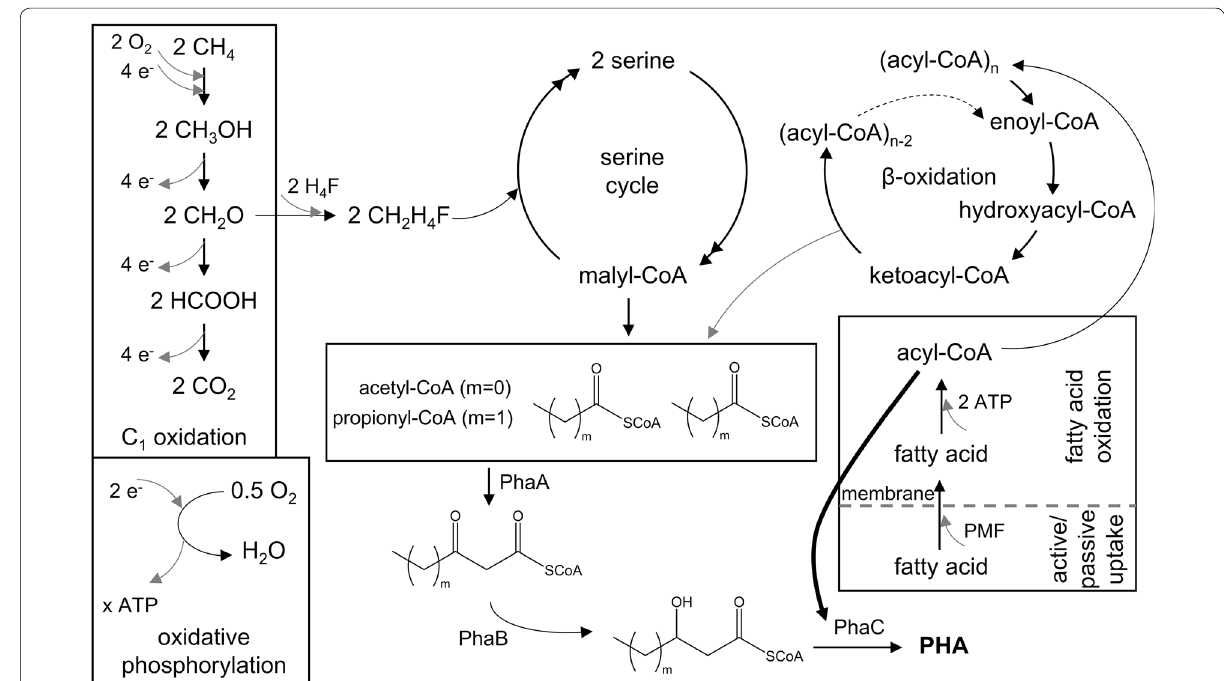
Fig. 6 C 1 -oxidation dependent synthesis of PHAs in serine-cycle methanotrophic bacteria. The bold arrow denotes an acyl-CoA pathway likely activated by ω-hydroxyalkanoate